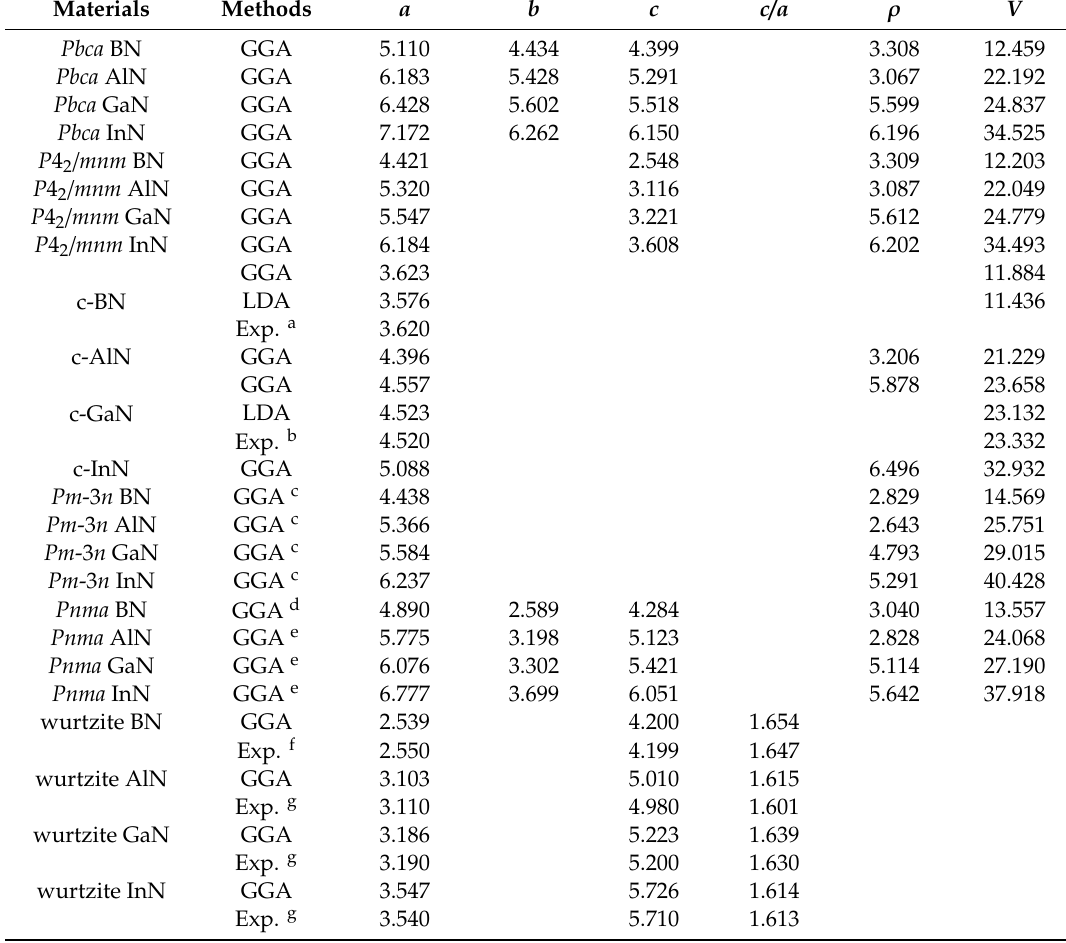
Table 1. Lattice parameters and volumes of Pbca XN, P 4 2 / mnm XN, c-XN, Pm -3 n XN, wurtzite XN, and Pnma